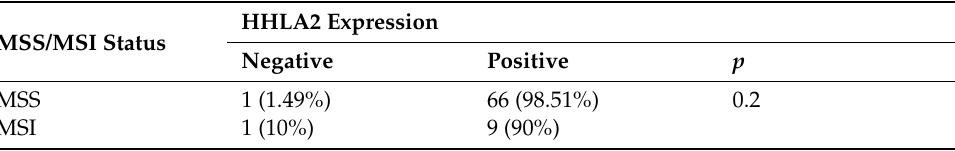
Table 3. Association between HHLA2 IHC expression and MSI/MSS status of tumors. Chi- square Table 2. HHLA2 Immunohistochemistry expression in tumor cells (N = 77).